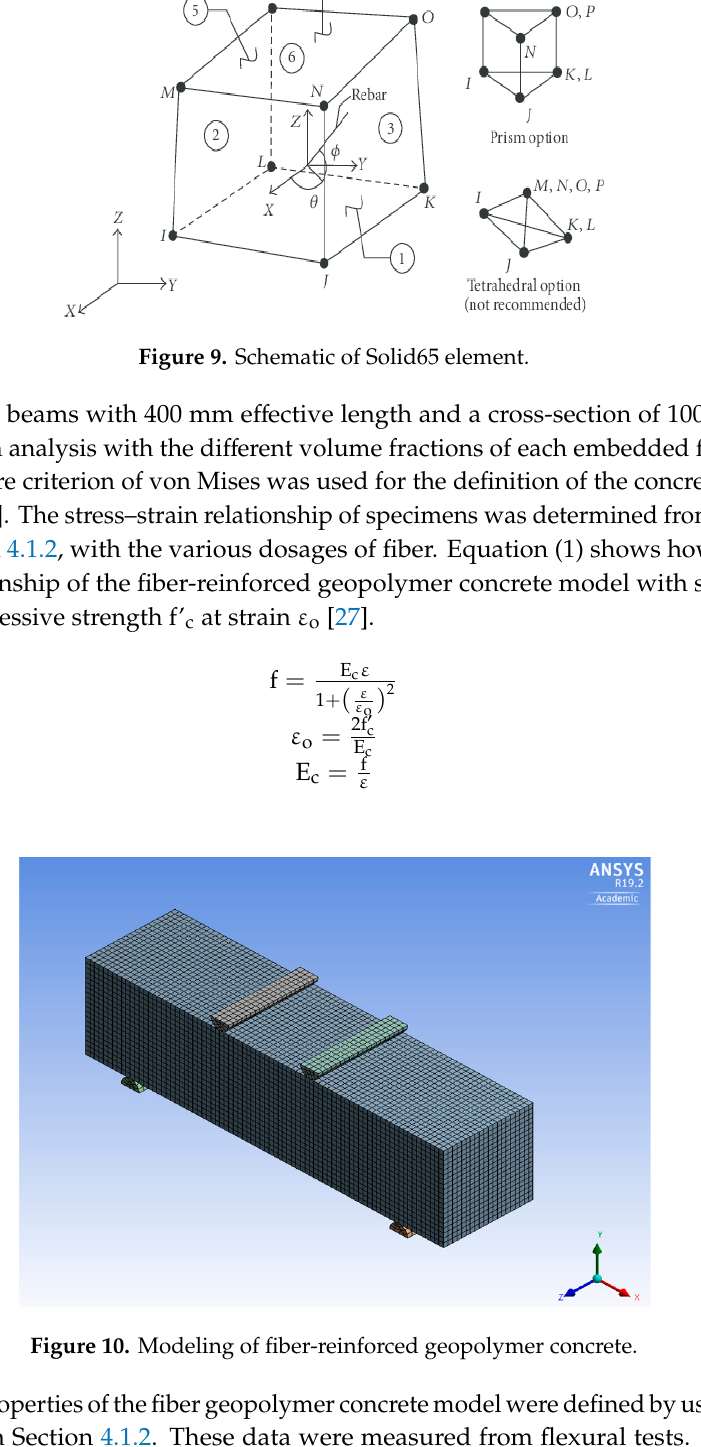
Figure 10. Modeling of fiber-reinforced geopolymer concrete.